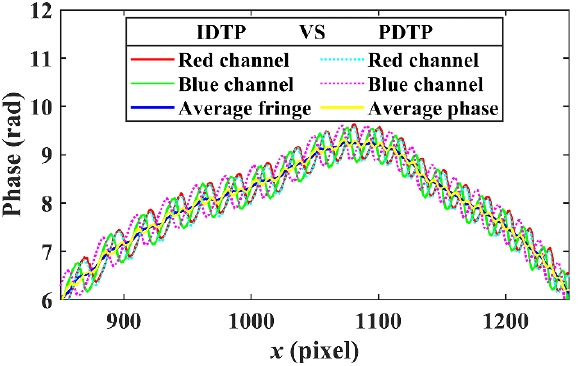
Figure 9. One cross section of the recovered absolute phases of the sculpture.